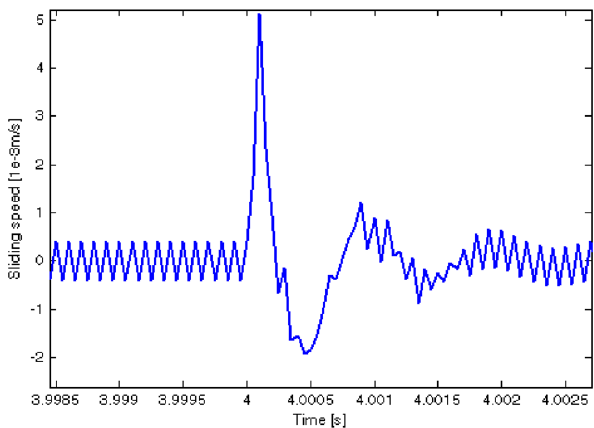
Figure 13. Sliding speed predicted using Stribeck model (at around the 4th second).